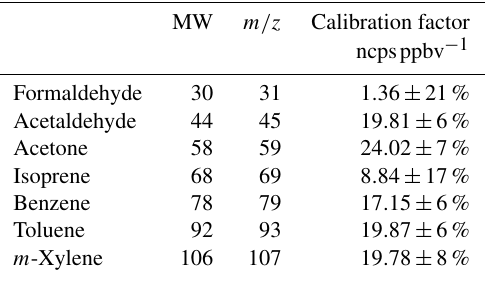
Table 2. The PTR-MS calibration factors for each of the VOCs included in this work, normalized to 10 6 counts per second (cps) signal = 13 . 5 million cps). The uncertainty limits represent ± the standard deviation ( ± 1 σ ) of the daily mean in the calibration mea- surements over the campaign average. N represents the number of 30min calibration periods used to calculate the sensitivity statis- tics. The average calibration for formaldehyde is presented in the table; the ambient data processing for formaldehyde utilized a lin- ear equation calibration factor = 16 . 08 − 0 . 232 ·[ H 2 O ] , where the water vapour concentration is in gm − 3